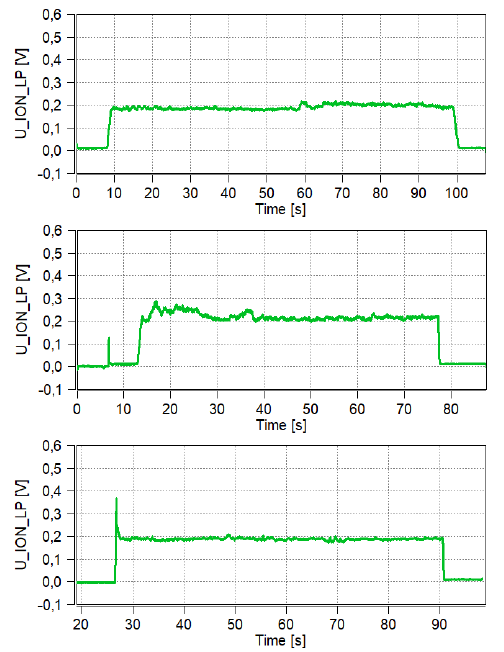
Fig. 8. Ionization signal waveforms using spark plug 2 with equal spacing (from the top): 0.4, 0.8 and 1.2 mm